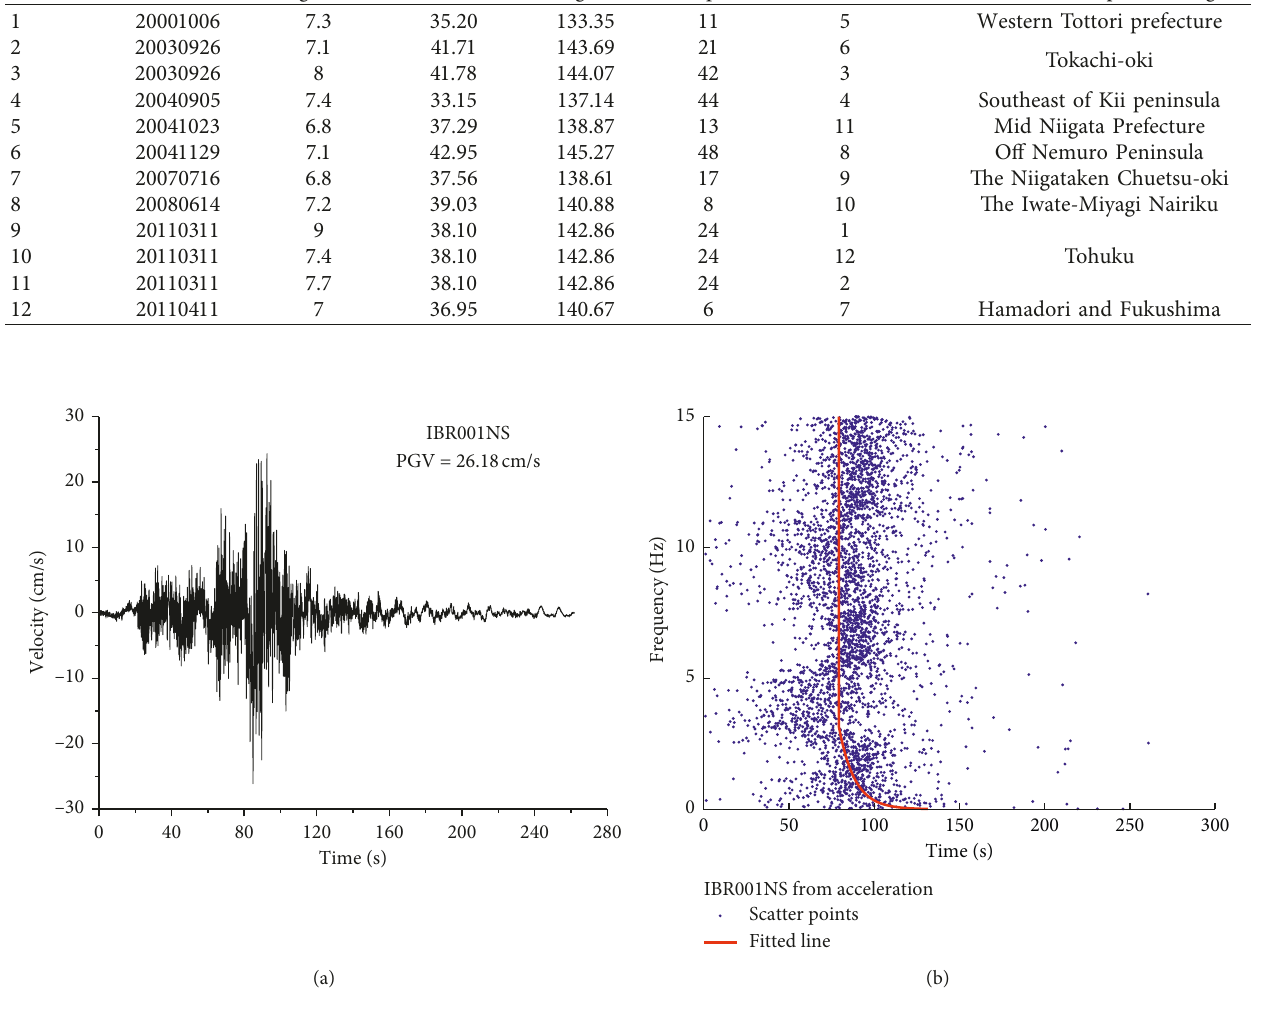
Figure 5: The record from IBR001NS, Tohuku, M9, earthquake shows that envelope delays coincide with the waveform in time series, resulting from three successive fault